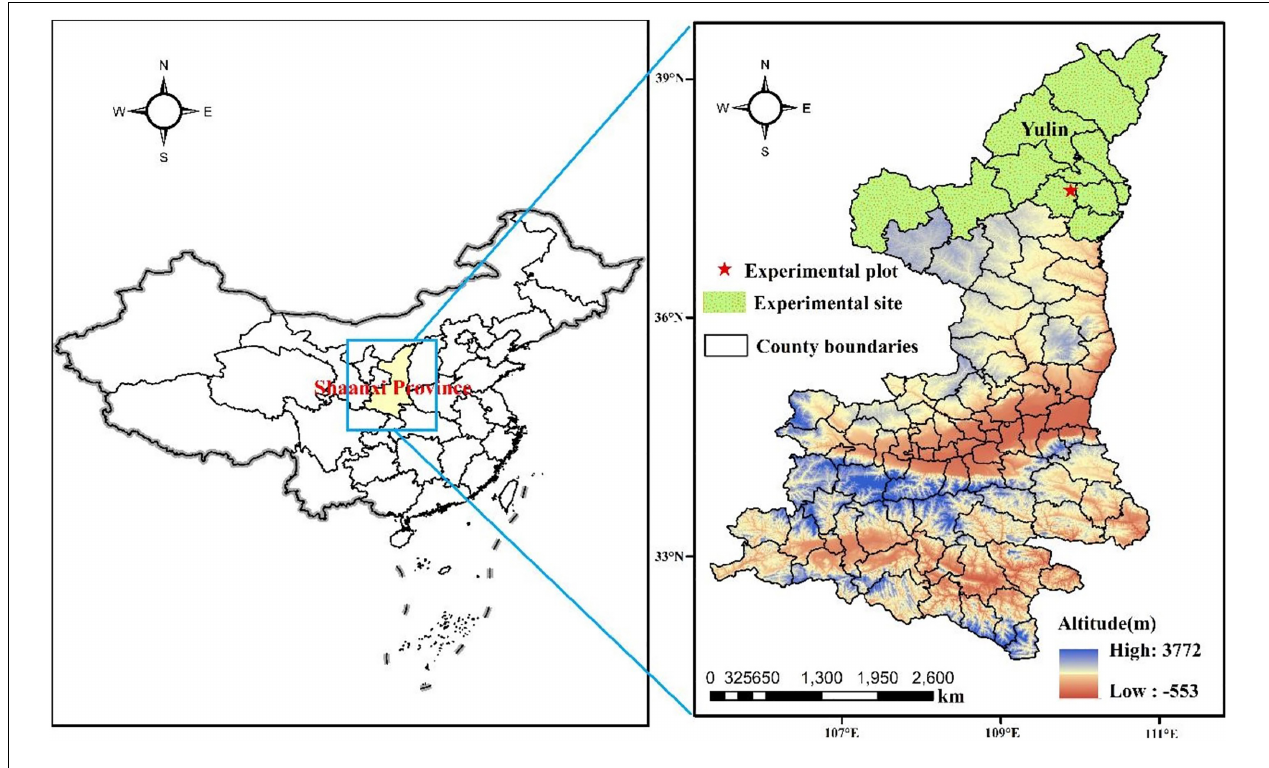
FIGURE 1 | The location of the experimental site. TABLE 1 | The phenological stage was divided of apple in experimental